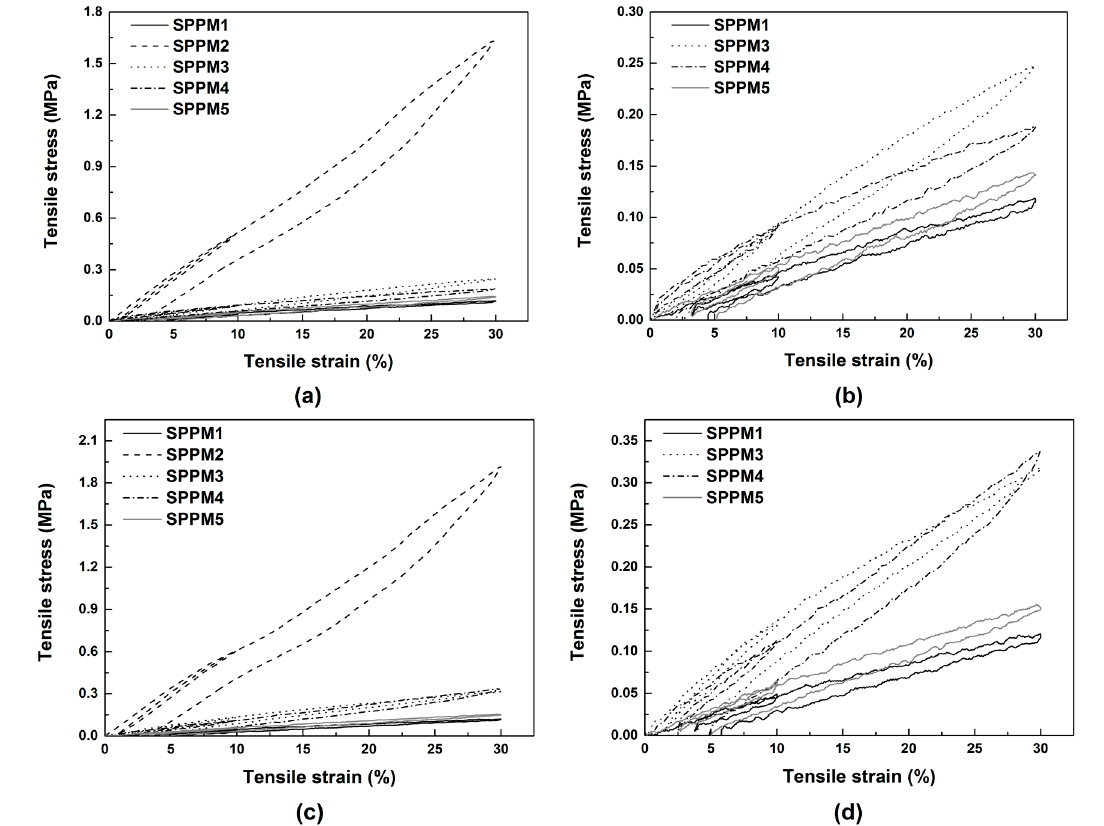
Figure 12. Typical stress vs. strain relationships under uni-axial cyclic tension at room temperature in all samples programmed with 20% strain ( a ) and zoom-in view for samples excluding SPPM2 ( b ); and programmed with 50% strain ( c ) and zoom-in view for samples excluding SPPM2 ( d ).